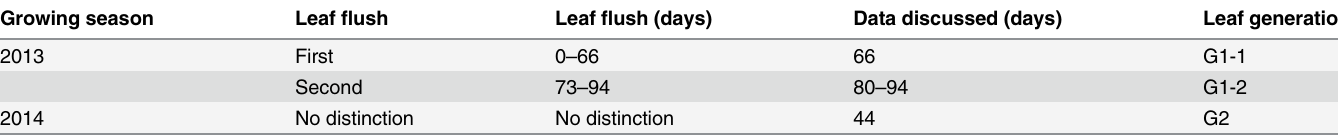
Table 3. Growth seasons and leaf generations. The distinction of growth seasons and leaf generations as discussed in this paper. Growing